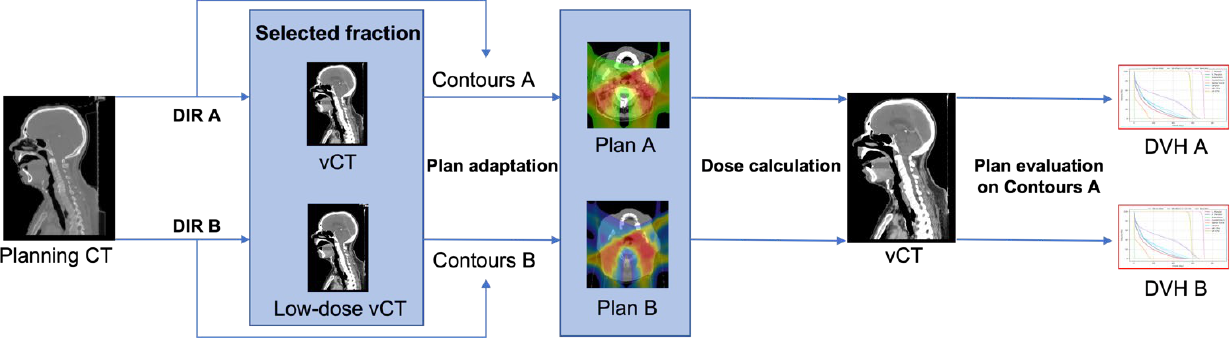
Figure 4. Pair of vCT images of a patient: standard protocol ( left ) and low-dose protocol ( right ).